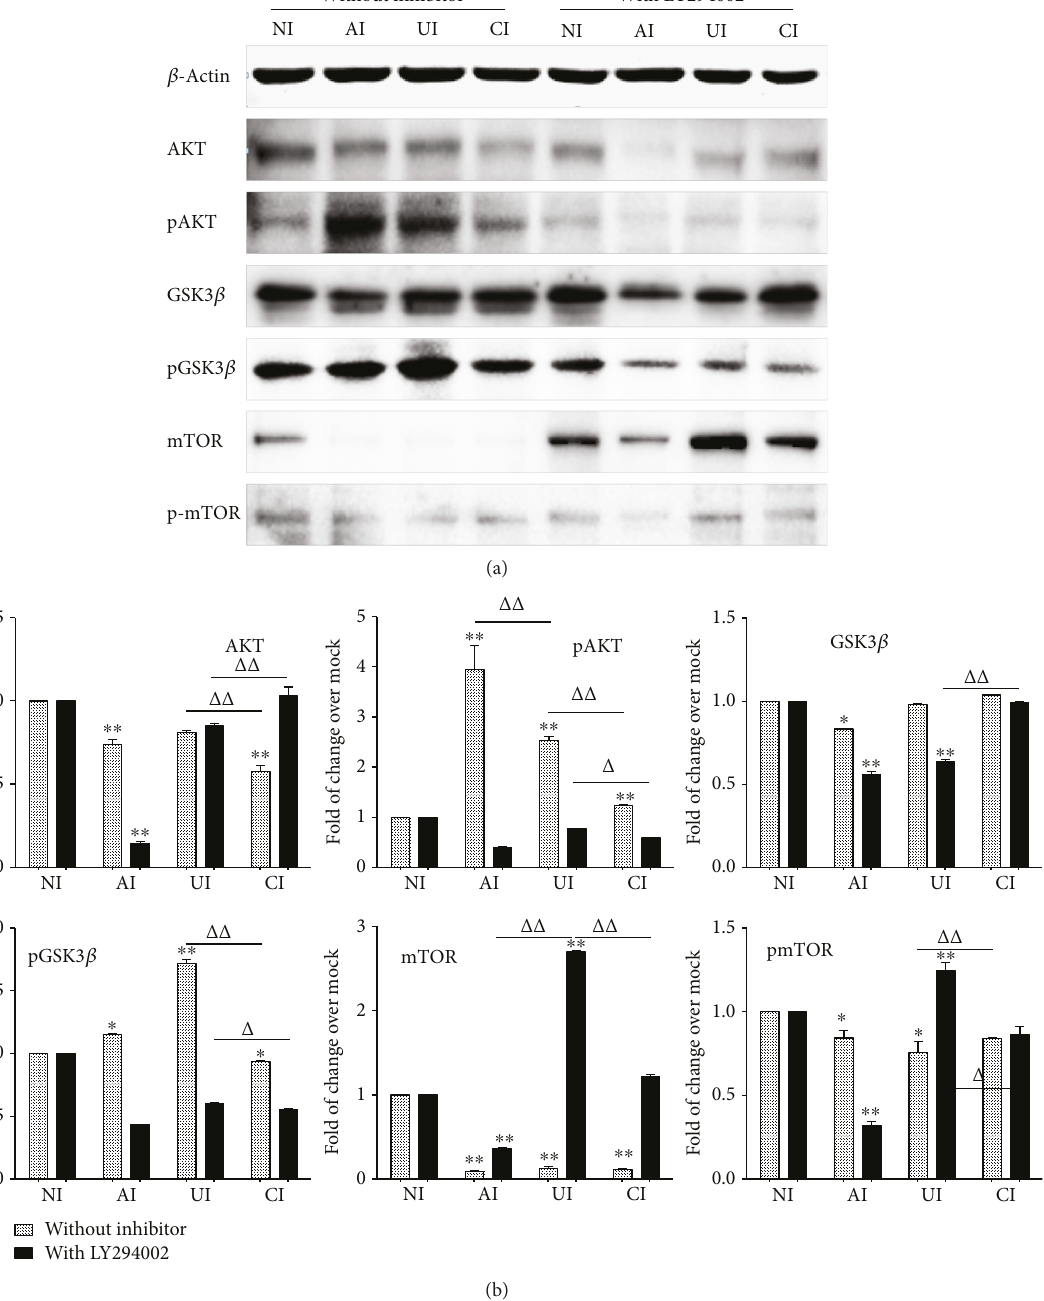
Figure 6: Impact of PI3K/Akt/GSK3 β /mTOR signaling in U937 cells in response to H37Rv infection. In the presence or absence of PI3K inhibitor LY294002, the coculture model of A549/U937 cells was infected with H37Rv mycobacteria from the upper chamber (A549 cells, AI), lower chamber (U937 cells, UI), or both chambers (A549 and U937 cells, CI) at a MOI of 3 for 18 h before the culture medium and U937 cells were harvested for analysis. (a) Representative blots of immunoblotting assay for the indicated components of PI3K/Akt/ GSK3 β /mTOR signaling showed an involvement of Akt, GSK3 β , and mTOR signaling in U937 cells of the coinfection model. (b) The fold of changes of proteins of interest in (a) semiquantitatively determined by densitometric assay using ImageJ software Fiji from three independent experiments; the ability of A549 cell-mediated reduction of Akt, GSK3 β , and mTOR signaling activity in U937 cells was lost in the presence of LY294002. Error bars represent the standard deviation (SD) from three independent experiments. Compared to noninfection (NI) control, ∗ p < 0 05 and ∗∗ p < 0 01 ; compared to the absence of LY294002, Δ p < 0 05 and ΔΔ p < 0 01 . NI: noninfected control; AI: infection was performed on A549 cell alone; UI: infection was performed on U937 alone; CI: infection was performed on both A549 cells and U937